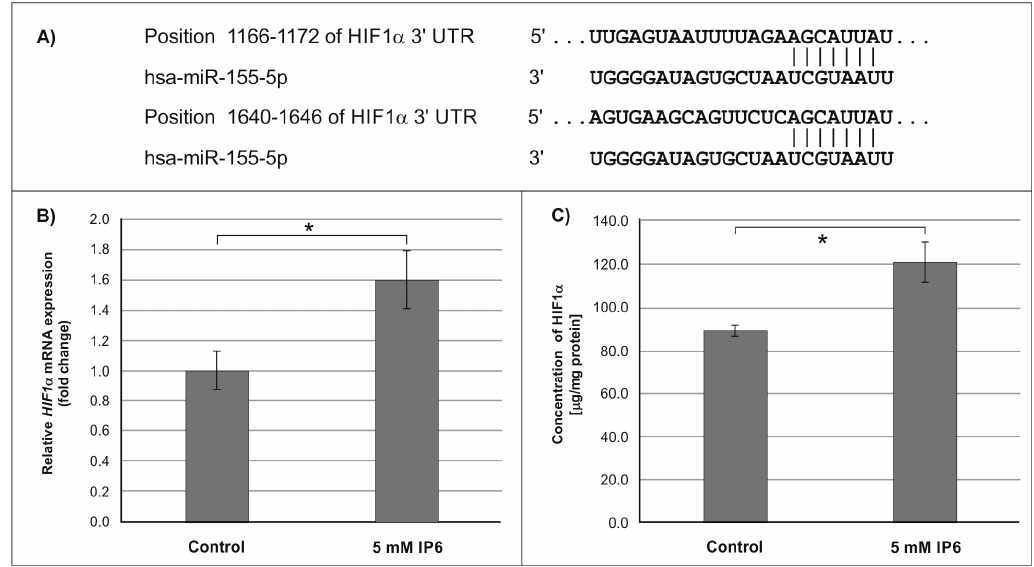
Figure 5. Effect of 5 mM IP6 on HIF-1 α gene expression in Caco-2 cells at 24 h. ( A ) Schematic of the putative binding sites of miR-155-5p in 3 ′ -UTR of HIF-1 α miRNA, as determined by bioinformatics analysis. ( B ) Changes in HIF-1 α mRNA expression in Caco-2 cells, as determined by RT-qPCR. ( C ) Changes in HIF-1 α protein concentration in Caco-2 cells, as determined by ELISA test. The results are presented as mean ± SD of three separate experiments; * p < 0.05 versus control.